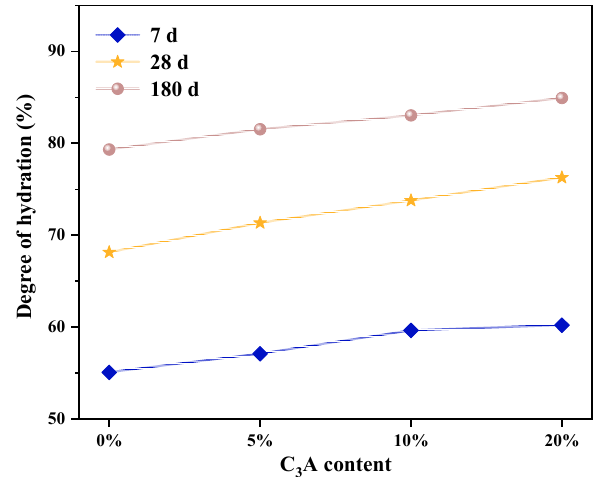
Figure 3. Degree of hydration of C 3 S-C 3 A paste under sulfate attack.